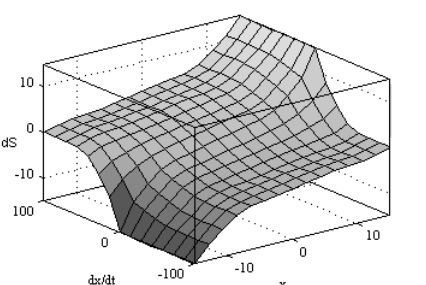
Fig 5. The sample surface illustrating dependencies between stick position X , its rate dx/dt and position of control surfaces dS